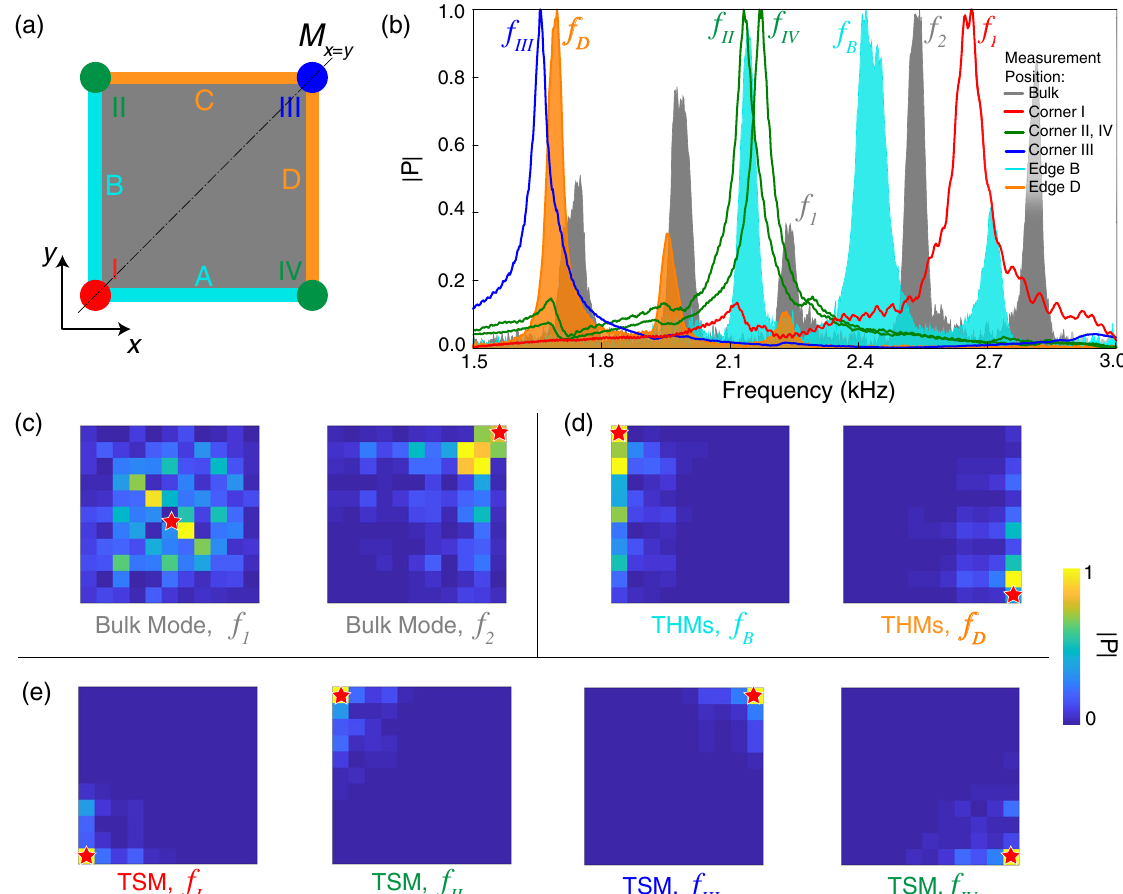
FIG. 4. Observation of THMs and TSMs. Here, the system is at ð ϕ x ; ϕ y Þ ¼ ð − 0 . 5 π ; − 0 . 5 π Þ . (a) A schematic drawing of the system, wherein the corners and edges are color labeled. Note that the system has mirror symmetry M x ¼ y . (b) The pressure response spectra. The gray areas represent the bulk response; the orange- and cyan-shaded areas are the edge responses; the four curves each represent the response at the correspondingly colored corner. The spatial field maps are shown when the system is excited in the bulk (c), at the edges (d), and at the corners (e) at the indicated frequencies. The red stars in (c) – (e) mark the excitation position. In (d), the field maps are confined at the excitation edges, indicating the observation of THMs in real space as TEMs. In (e), the modes are strongly localized at the excitation corners, indicating the existence of TSMs in real